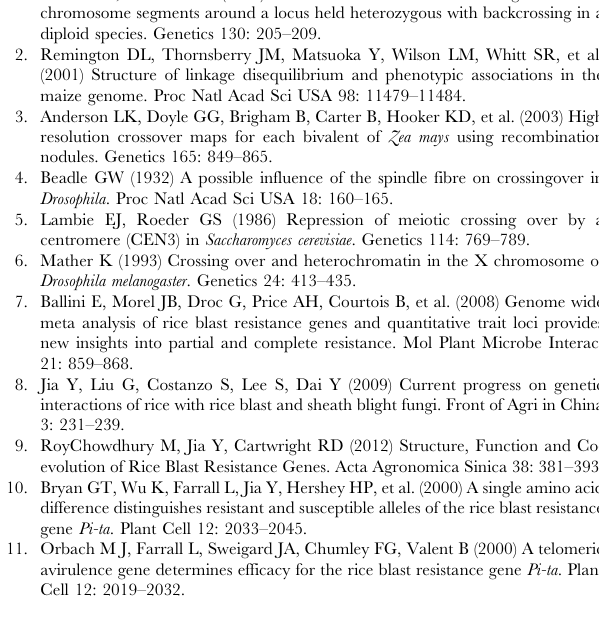
Table S5 SSR marker file for LJ mapping population. Table S6 Mapping profile for Cocodrie and MCR mapping population for JoinMap. Table S7 SSR marker file for Cocodrie and MCR mapping population. Table S8 Mapping profile for Katy and172 mapping population for JoinMap. Table S9 SSR marker file for Katy and 172 mapping population. Table S10 Mapping profile for KZ mapping population for JoinMap. Table S11 SSR marker file for Zhe733 and Katy mapping